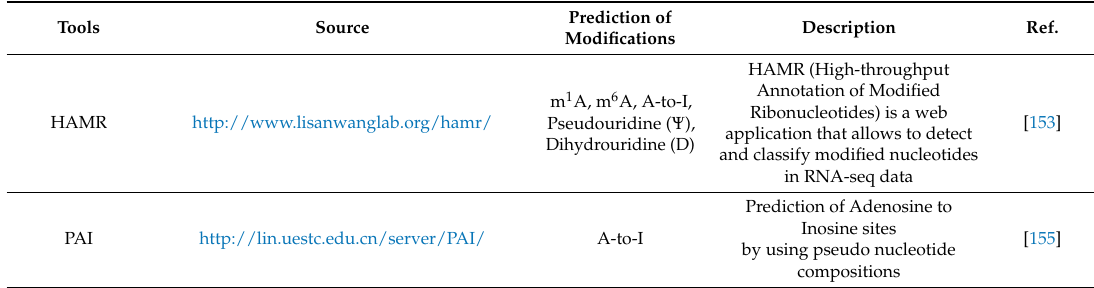
Table 2. Prediction tools of RNA